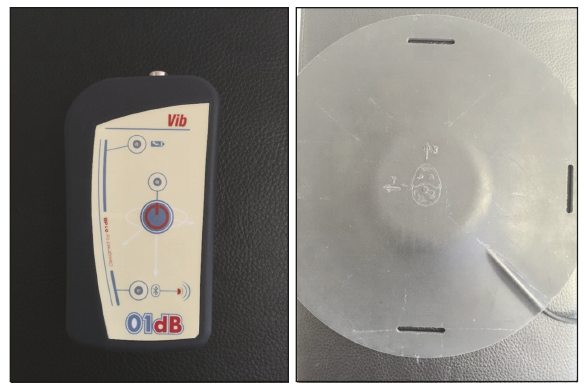
Figure 1: Vibration dosimeter VIB 008,